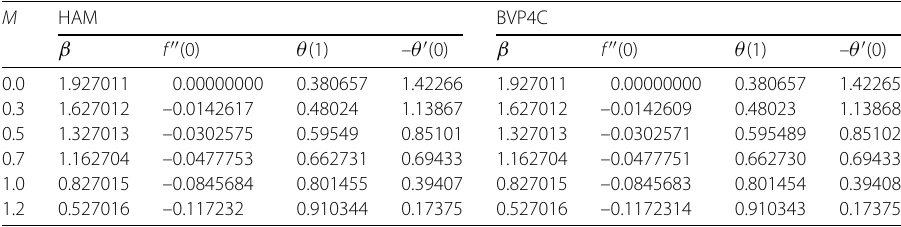
Table 9 Comparison of the values of β = Υ Mathematica package BVPh2.0 approximation and shooting method for the case β = 0.2, I 0 = 0, λ = 0.2, A = 0.3, N = 0.2, S = 0.4, Pr = 1, Ma = 1 and several values of M